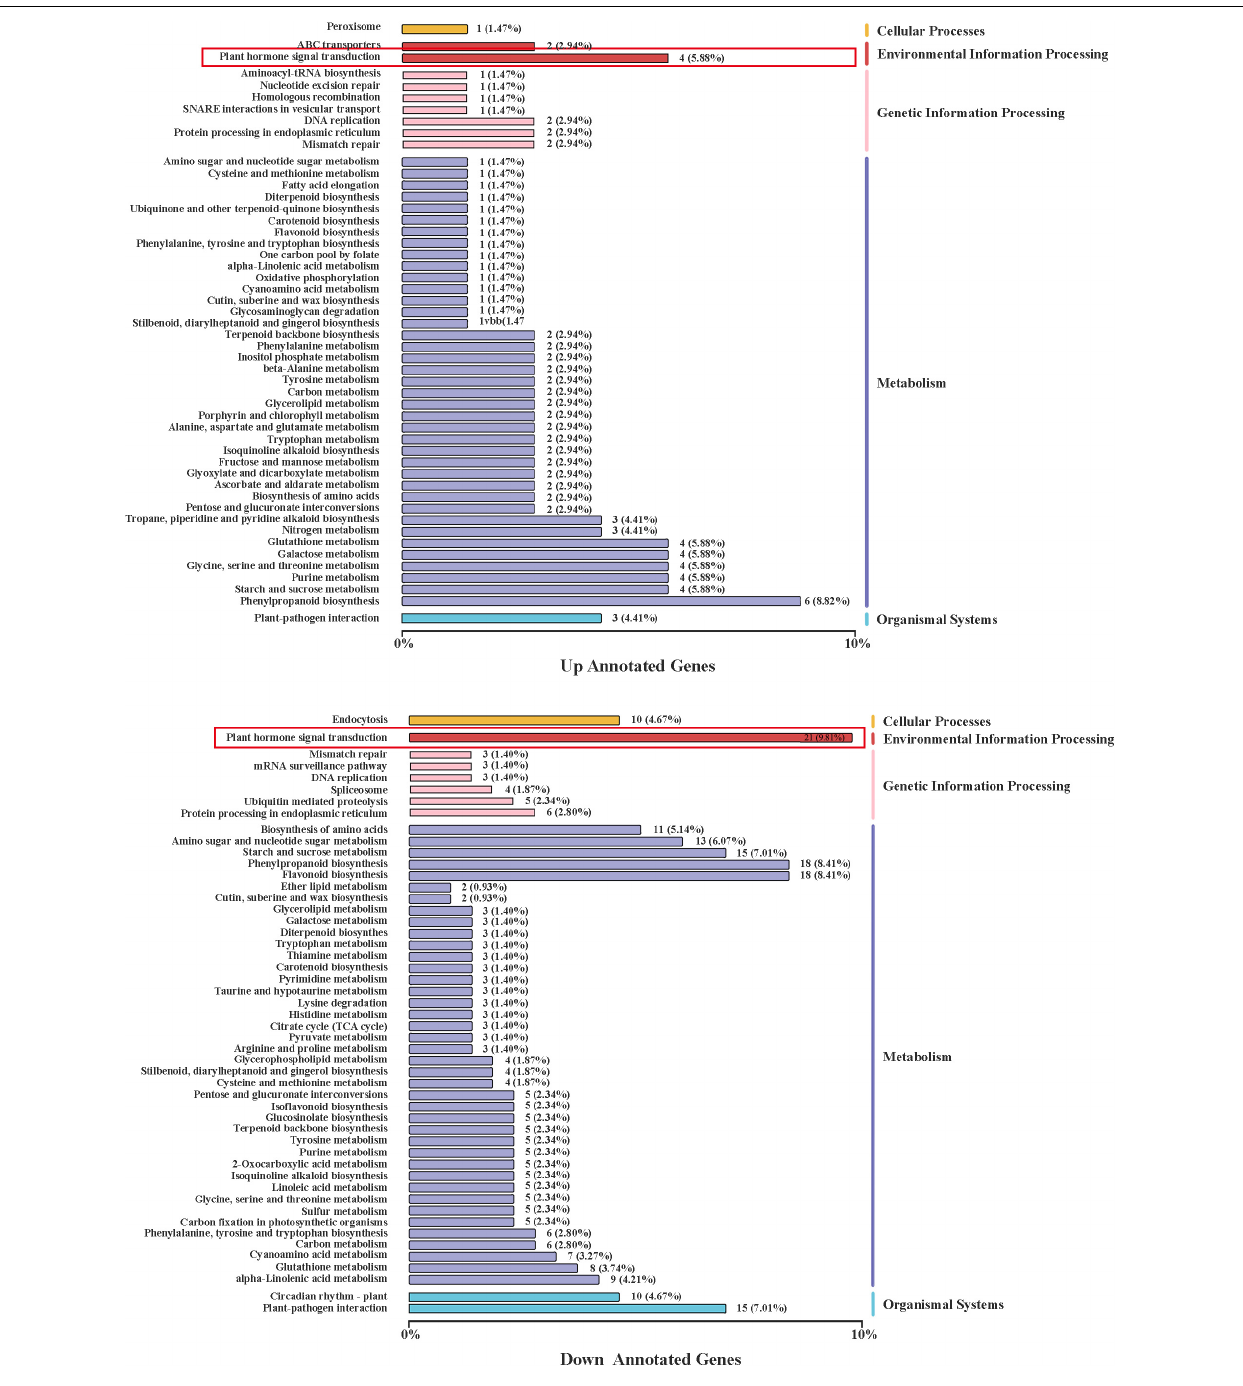
FIGURE 5 | Regulations of the KEGG